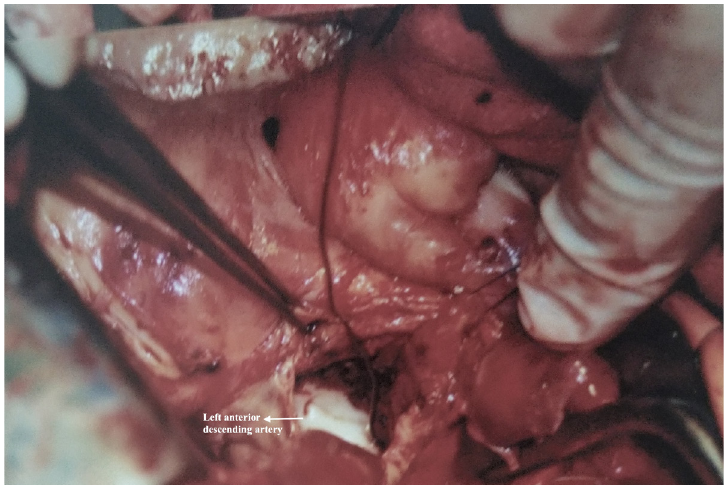
Fig. 2 - Perioperative image showing the left anterior descending artery and aneurysm sac.